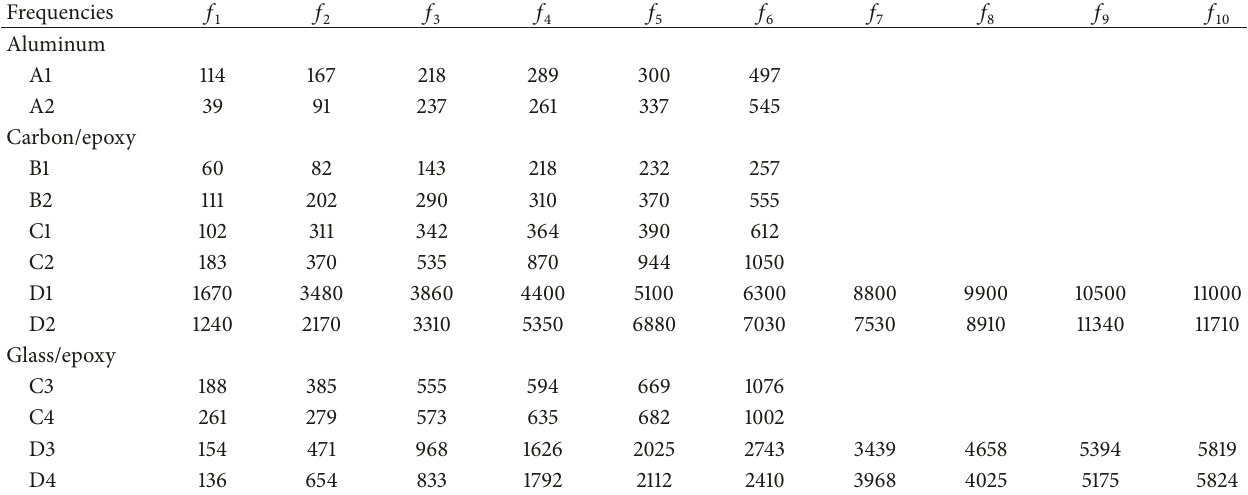
Table 4: Natural frequencies (Hz) of the aluminum, carbon/epoxy [8], and glass/epoxy plates obtained by modal test.